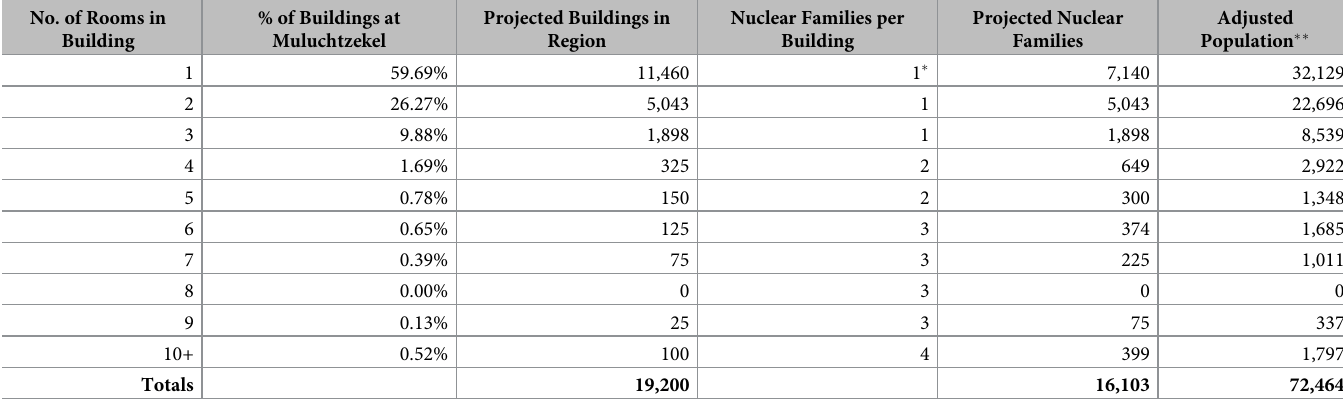
Table 11. Population projected on the basis of room statistics.